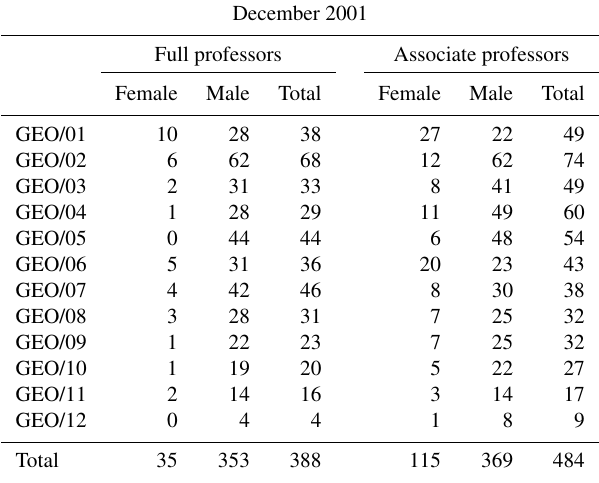
Table 2. Number of full and associate professors in all GEO scien- tific SSD (from 01 to 12) of the Italian university system relative to